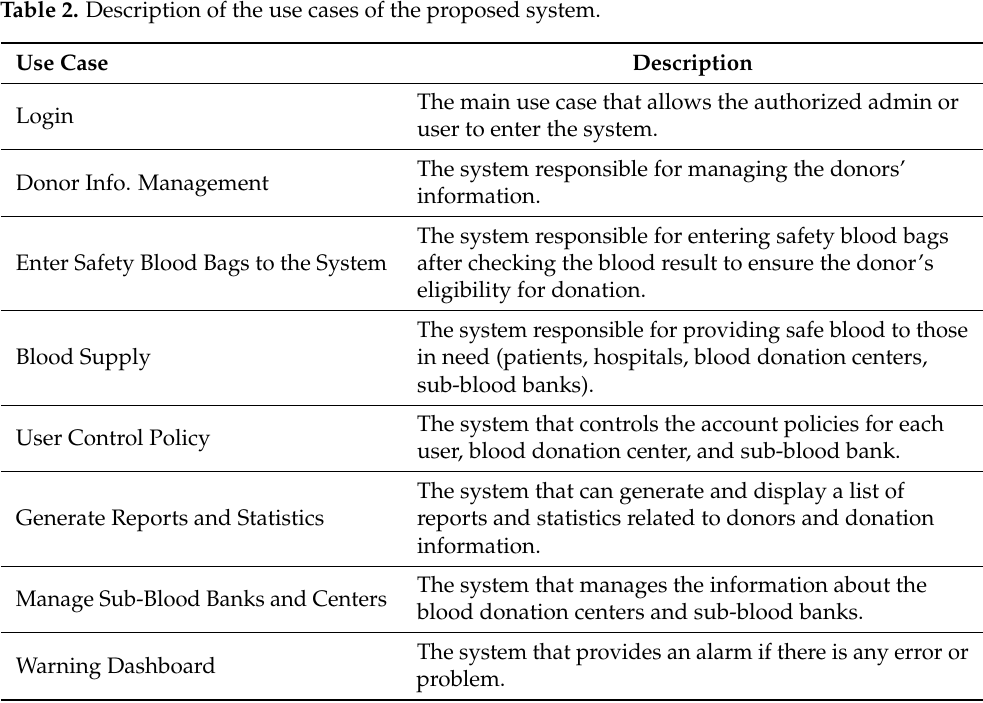
Table 2. Description of the use cases of the proposed